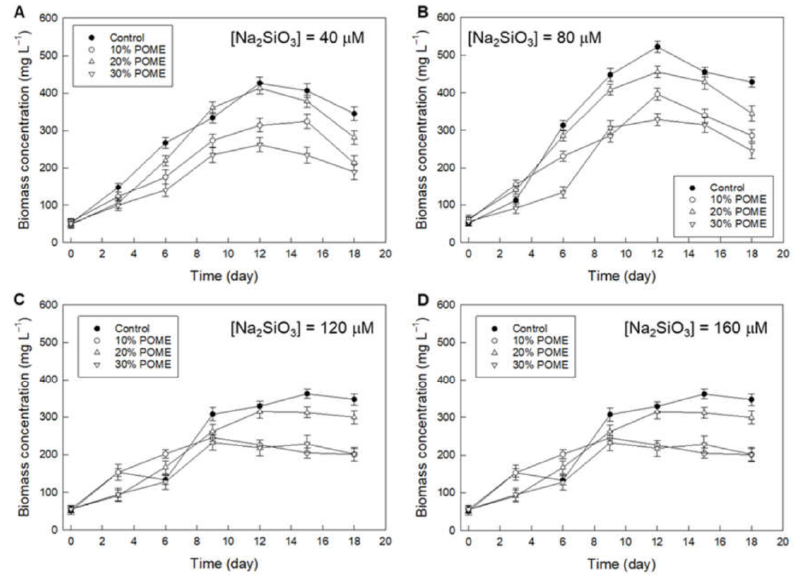
Figure 2. Biomass growth profiles in different media under continuous illumination (200 µ mol photons m − 2 s − 1 ). Initial concentrations of sodium silicate (Na 2 SiO 3 ) were ( A ) 40 µ M; ( B ) 80 µ M; ( C ) 120 µ M; ( D ) 160 µ M. Data are mean values ± standard deviation (n =